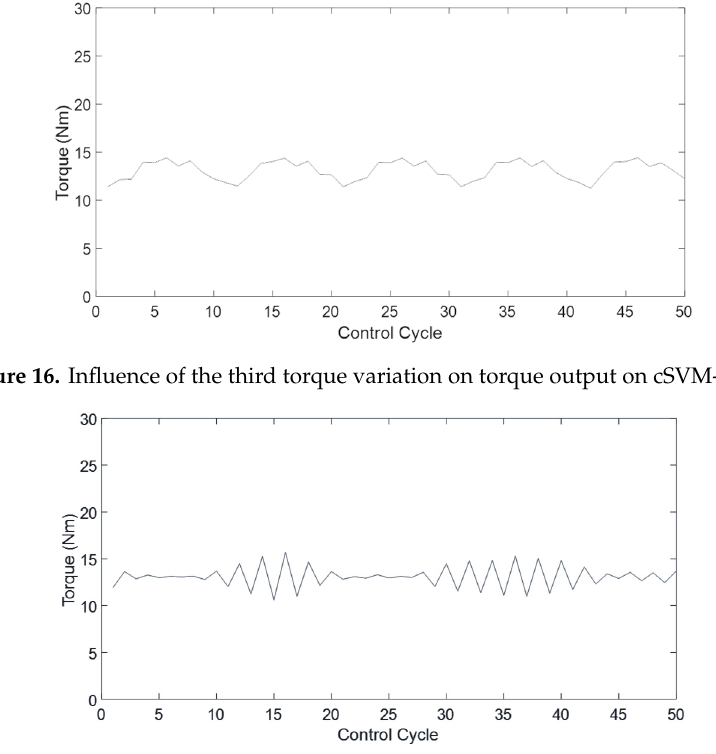
Figure 17. Influence of the third torque variation on torque output on proposed rSVM-DTC. As indicated in Equation (16), the fourth torque variation term is related to flux linkage, which